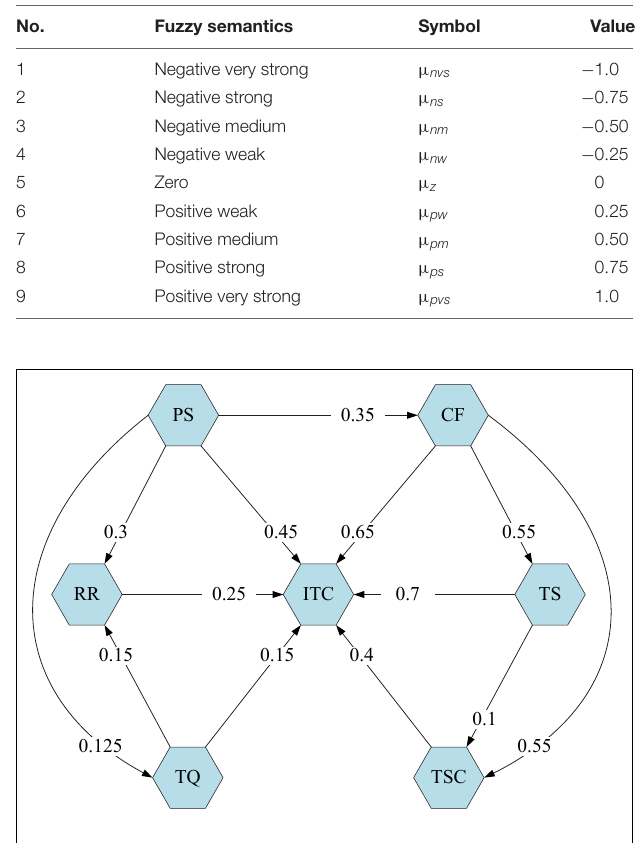
FIGURE 1 | FCM Model of Intelligent Transportation